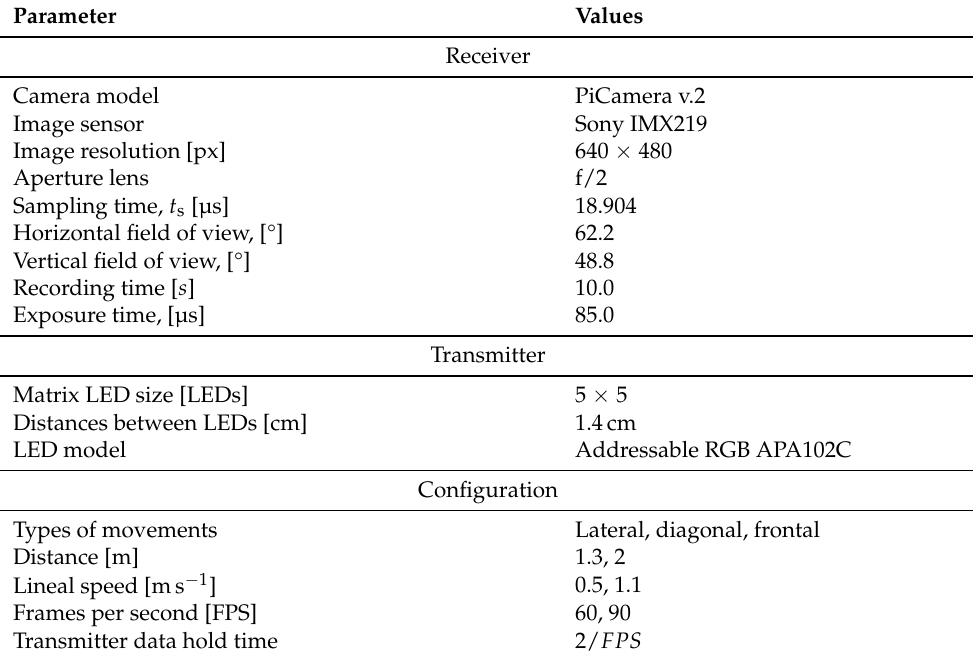
Table 2. Experiment’s key